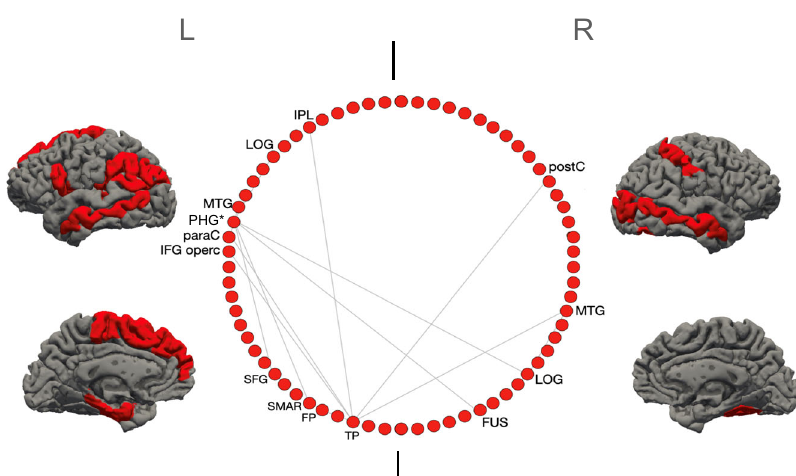
Fig. 5 Regions with the most signi fi cant difference in inter-regional correlations of cortical thickness between groups: the inter-regional correlations for these regions were signi fi cantly greater for VH patients. Shown in the circular plot, only the inter-regional correlations with a difference greater than 0.3 in the r 2 ; the region with the greatest number of signi fi cant inter-regional correlations, signi fi cant after multiple comparisons correction, is marked with a * (see also S8). IPL inferior parietal lobule, LOG lat. Occipital gyrus; MTG middle temporal gyrus, PHG parahippocampal gyrus; paraC paracentral gyrus; IFG opercularis inferior frontal gyrus, SFG superior frontal gyrus, SMAR supramarginal gyrus, FP frontoparietal thickness; TP temporoparietal, FUS fusiform gyrus, postC postcentral gyrus. The two vertical lines separate L and R hemisphere regions (left on